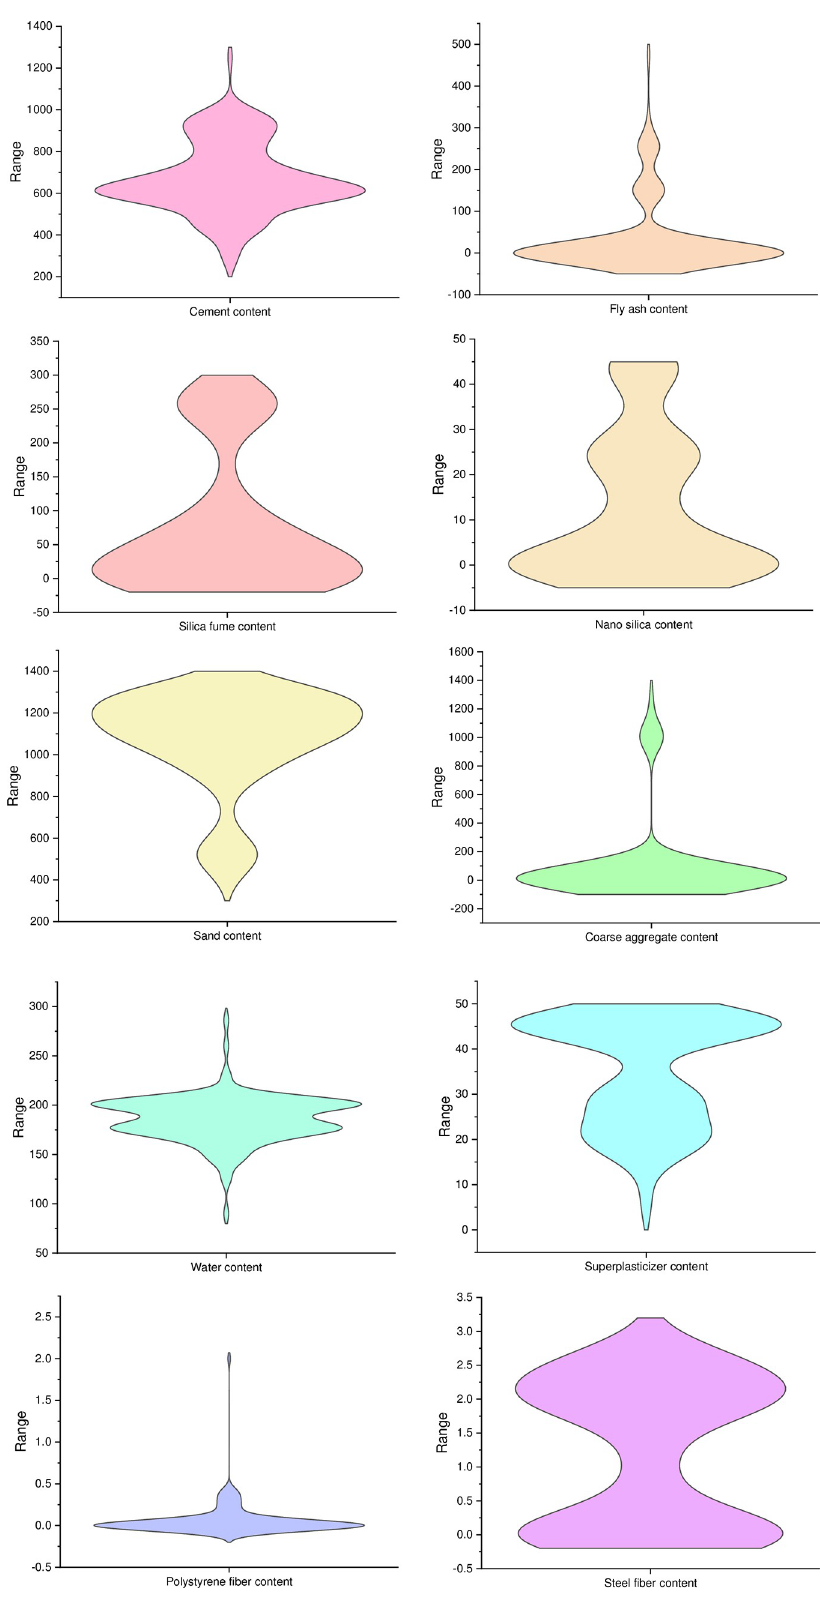
Fig 1. Violin plot for flowability input